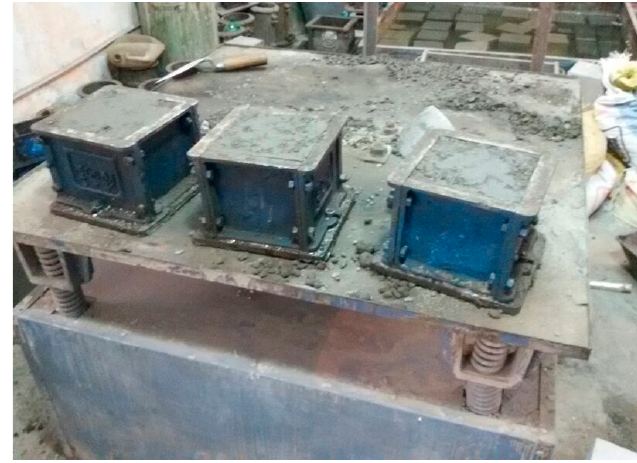
Figure 6. Concrete specimen in the mould on vibrating table. Table 6. Work plan for compressive strength test on cement matrix.